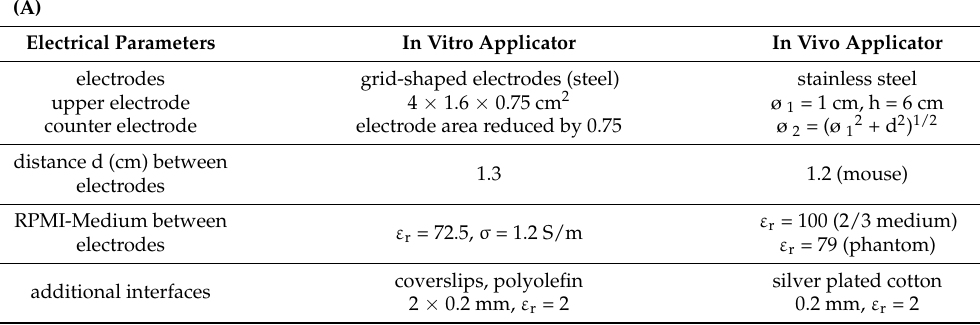
Table 1. ( A ) Electrical parameters (electrode size A, relative permittivity ε r , and electric